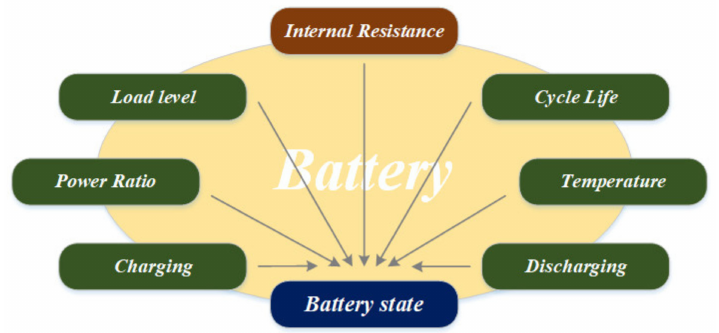
Figure 1. Factors affecting the state of a battery.